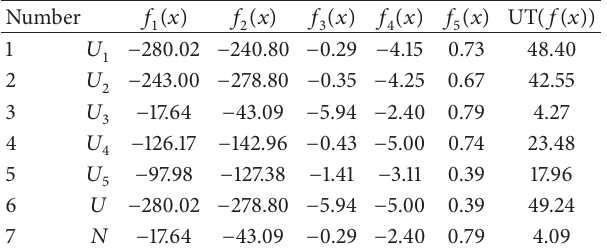
Table 6: The ideal and nadir points for Example